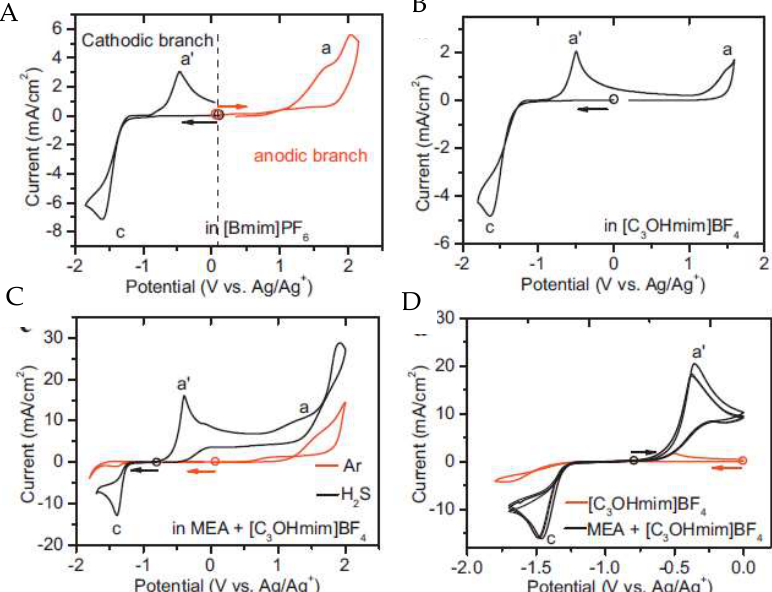
Figure 11. Cyclic voltammograms of H 2 S at the Pt microdisk electrode (diameter = 100 μm) in different electrolytes. A is [bmim][BF 4 ]; B is [C 3 OHmim][BF 4 ]; C is [C 3 OHmim][BF 4 ] with MEA and atmospheric gases and D is a comparison of cyclovoltamograms between [C 3 OHmim][BF 4 ] and [C 3 OHmim][BF 4 ] with MEA. Scan rate: 50 mV s −1 ; the circle indicates the open cell potential (OCP) of each system, and the arrow indicates the start direction of the potential scan from OCP. Reproduced with permission from [57], copyright 2018, Elsevier.